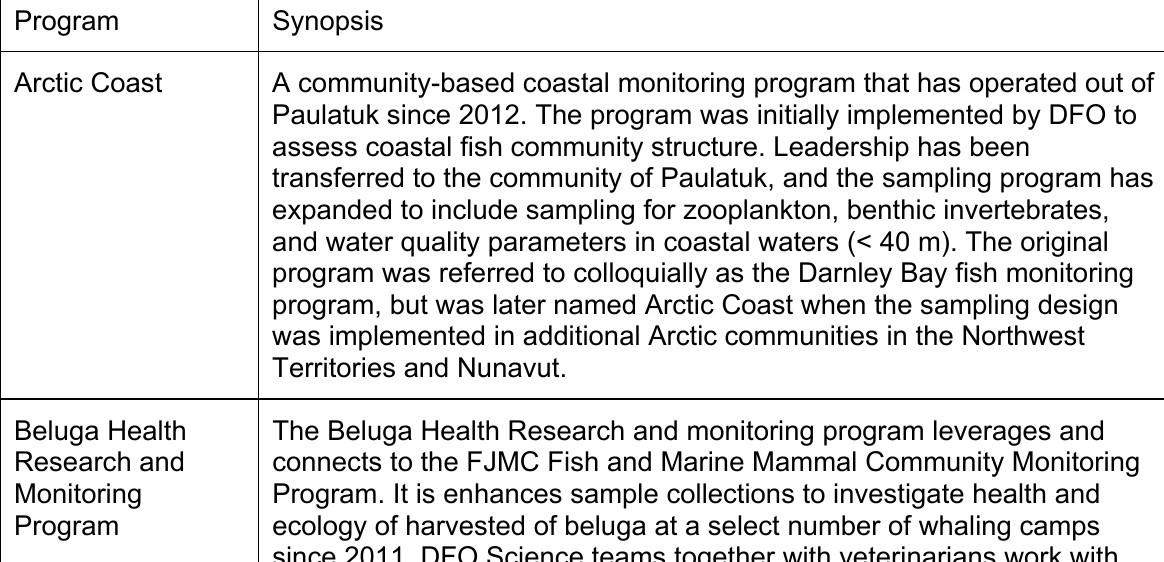
Table D1. Brief synopses of the scope, timing, and objectives of the major monitoring and research programs (in alphabetical order) that are mentioned frequently in this document because they collected data in the vicinity of the ANMPA pertinent to several monitoring indicators. The following is not an exhaustive list of all data collection programs mentioned in this